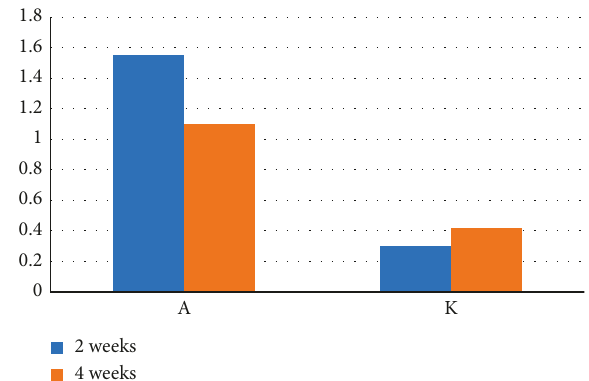
Figure 21: Dynamics of bone formation on the surface of the interalveolar septa after the formation of a bone tissue defect and introduction of suspensions of calcium hydroxide alone and cal- cium hydroxide with nanodispersed cerium dioxide (A—with cerium dioxide and K—without cerium